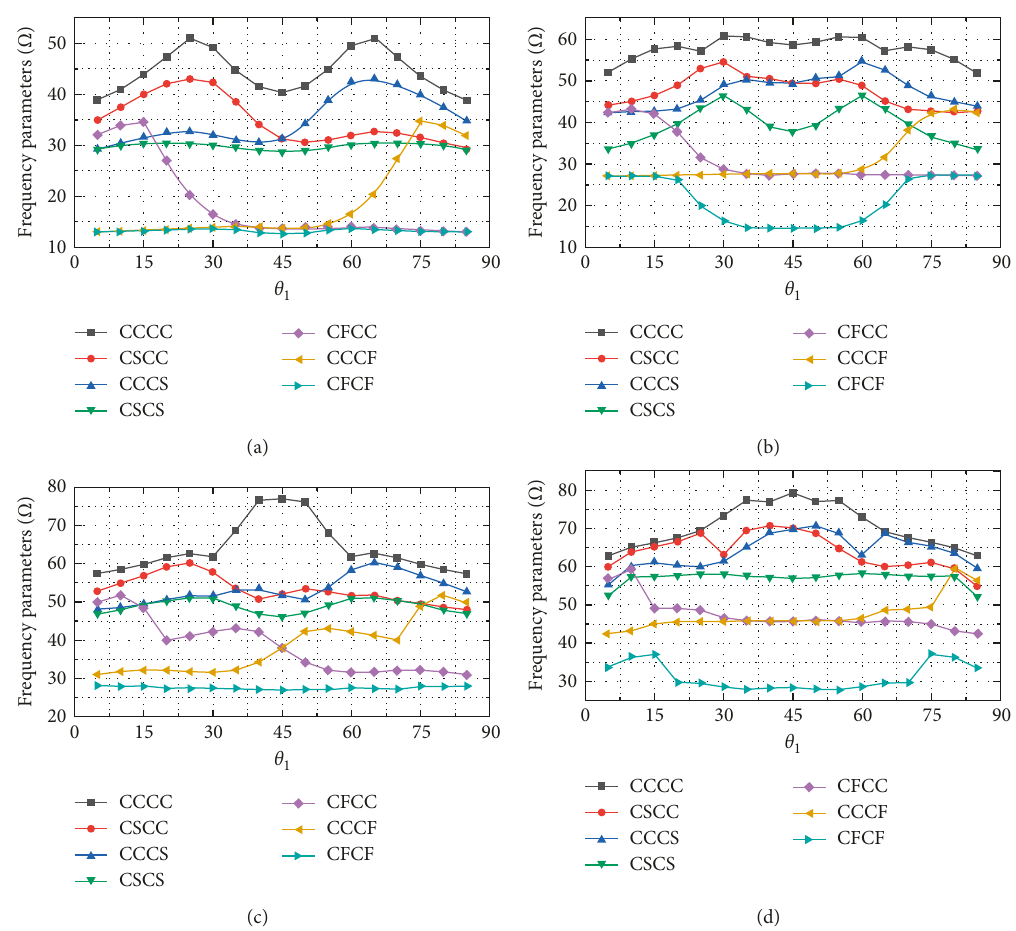
Figure 8: Variation of frequency parameters of functionally graded open cylindrical shell with an axial bulkhead according to cir- cumferential position of bulkhead ( R